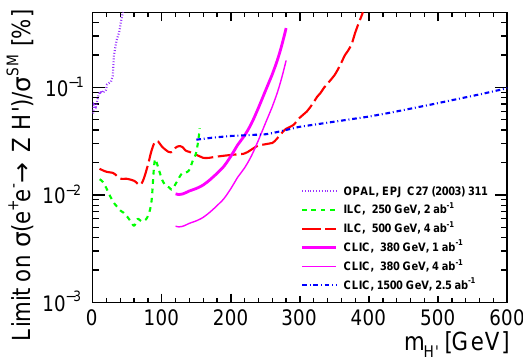
− 1 Figure 3: Expected sensitivity of CLIC running at 380 GeV (thick pink line for 1 ab − 1 and thin pink line for 4 ab ) and 1.5 TeV (dotted-dashed blue line). For compari- son, we show the existing limit from LEP (dotted violet line) [ 16 ] and the expected sensitivity of ILC running at 250 GeV (dashed green line) and 500 GeV (long-dashed (cid:48) red line) [ 17 ] . Expected cross section limits for new scalar H production are shown as a function of its mass, relative to the expected SM Higgs production cross